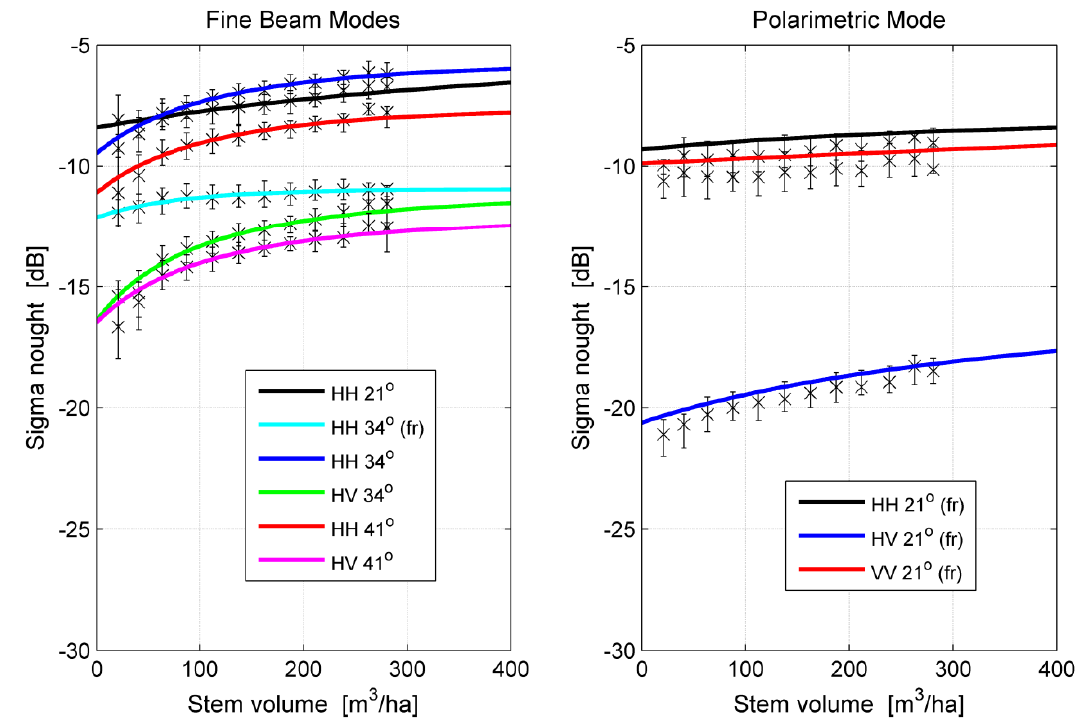
Figure 4. Measured and modeled PALSAR backscatter as a function of stem volume for Krycklan. The model curves are based on Equation (1). The crosses and the vertical bars represent the median backscatter and the interquartile range in 25 m 3 /ha large intervals of stem volume. All data acquired under unfrozen conditions unless specified in the legend (fr =